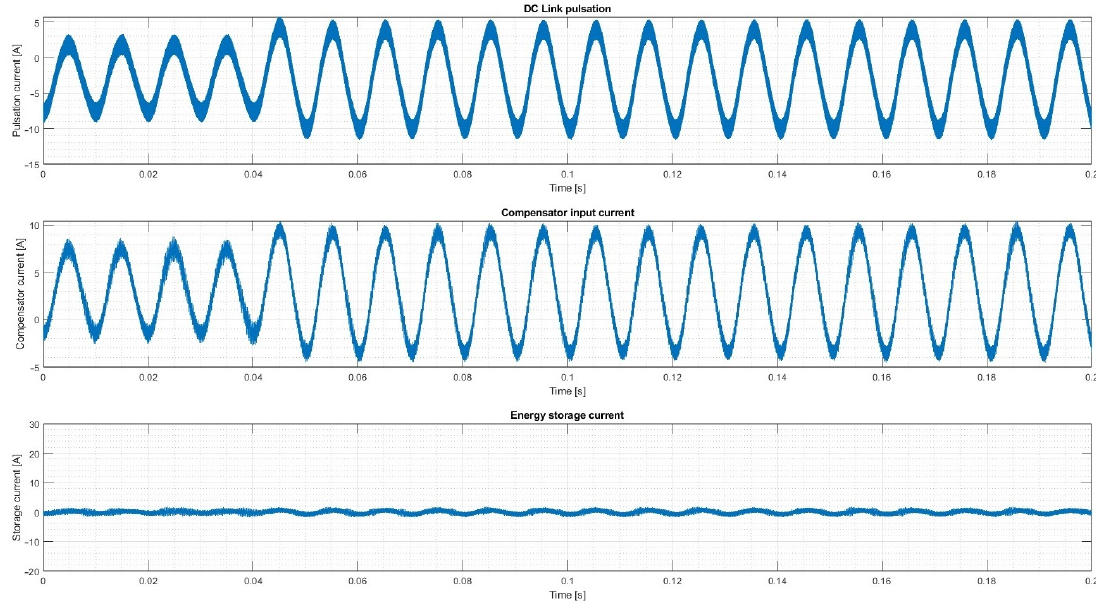
Figure 12. Step change of the pulsation in the DC link current.